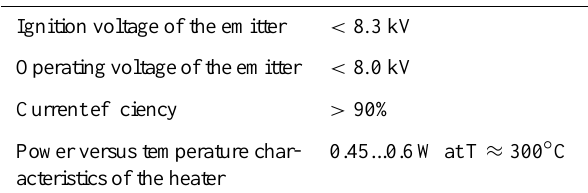
Table 3. Selection criteria for ion